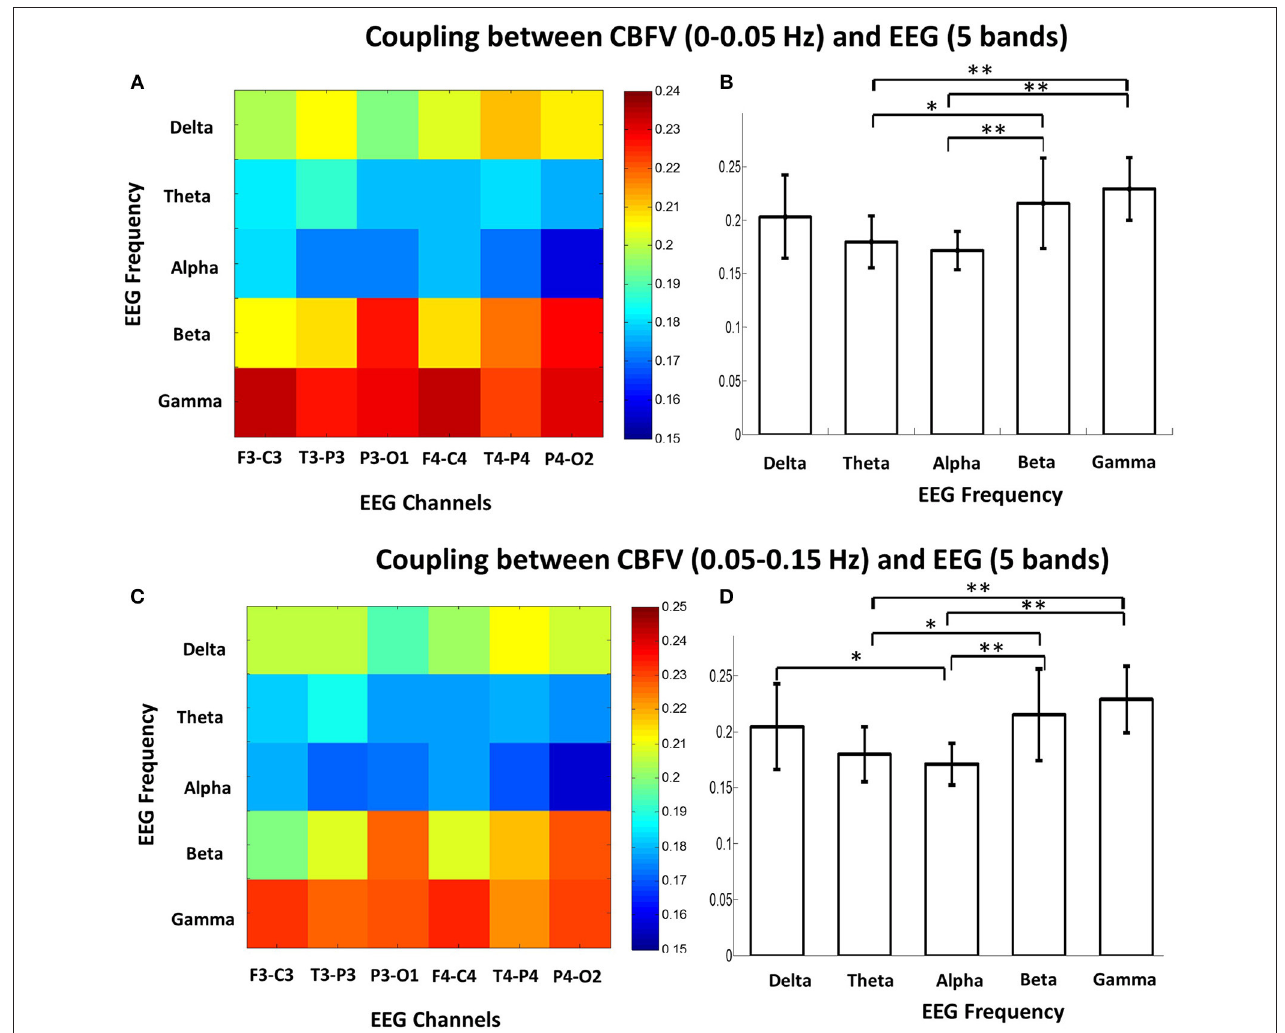
FIGURE 3 | (A) Mean phase-amplitude cross-frequency coupling (PAC) between CBFV (0–0.05Hz) and EEG of six channels in five frequency bands ( δ , θ , α , β , γ ) of the 16 patients. (B) Statistical comparison of mean PAC between CBFV (0–0.05Hz) and EEG in the 5 frequency bands ( δ , θ , α , β , γ ). The PAC in β and γ bands were significant higher than the other bands. One star means p < 0.05; two stars means p < 0.01. (C) Mean PAC between CBFV (0.05–0.15Hz) and EEG of six channels in five frequency bands of the 16 patients. (D) Statistical comparison of mean PAC between CBFV (0.05–0.15Hz) and EEG in the 5 frequency bands. The PAC in β and γ bands were significant higher than the other bands. CBFV, cerebral blood flow velocity; ABP, arterial blood pressure; EEG,